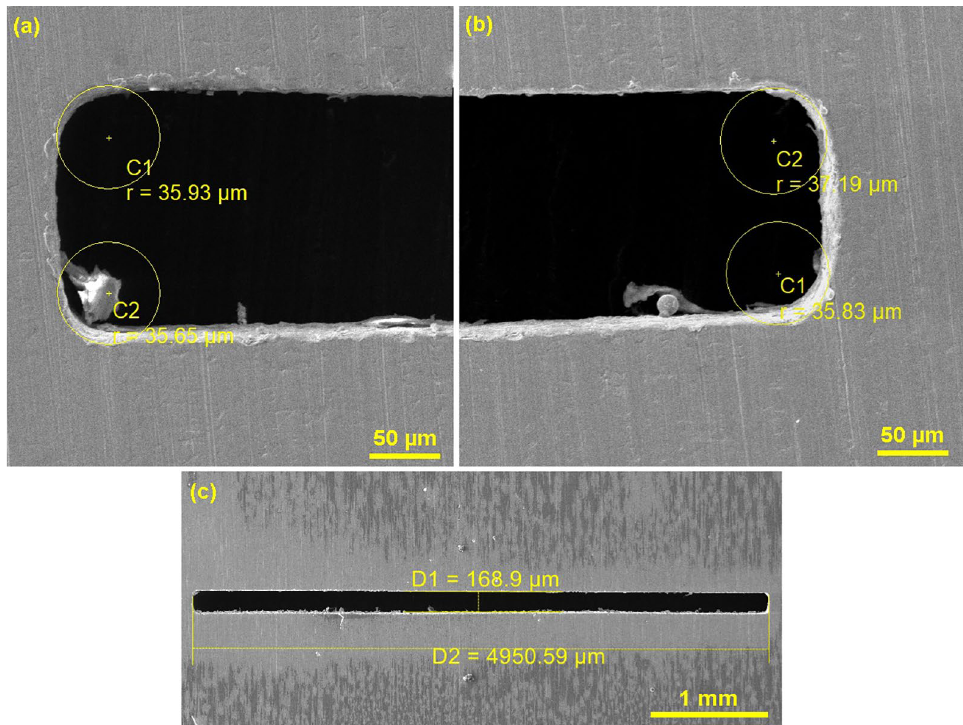
Figure 6. Slot made on the basis of optimized parameters from multi-criteria optimization (edited in program Adobe Photoshop www. adobe. com/ cz/ produ cts/ photo shop. html) ( a , b ) slit corners, ( c ) whole